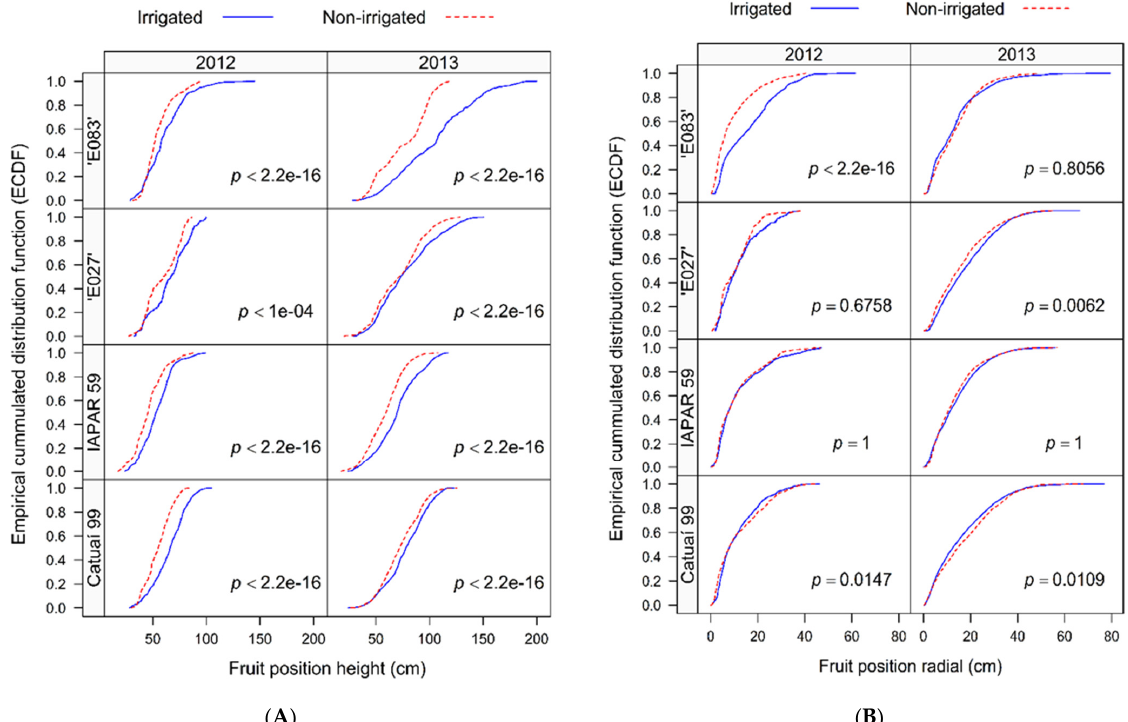
Figure 4. Empirical cumulative distribution function (ECDF) for berries along the ( A ) height of the canopy and ( B ) radial plant profile analyzed for four genotypes of Coffea arabica cultivated under two water regimes (irrigated and not irrigated). The p ‐ values are shown ( n = 4), comparing water regimes, separately for each genotype and harvest year (2012 and 2013). Additionally, the radial berry distribution (horizontal distribution over x ‐ and y ‐ axes) was also assessed, showing slightly delayed berry accumulation over the plagiotropic branches in NI compared to IRR in Catuaí 99 plants, in both harvest years (Figure 4B). The opposite, i.e., the delayed berry accumulation over the plagiotropic branches in IRR than in NI plants was calculated for ‘E083 in the 1st harvest year and for ‘E027 ′ the 2nd harvest year. The radial berry occupation zone referent to trunk attained the maximum from ca . 40 cm (‘E027 ′ ) to 60 cm (‘E083 ′ ) in the 1st harvest year. In the 2nd harvest year, the radial zone of berry occupation attained the maximum from ca . 60 cm (Iapar 59) to 80 cm (‘E083 ′ and Catuaí 99). 3.3. Components of the Berry and Bean Yields at Plant Scale Dependent on Water Regime, Genotype, and Local Light Availability In the 1st harvest year (2012) the yield components (fresh dry mass (FM), dry mass (DM), processed bean mass (BM)), and mass performances were positively impacted by irrigation in the three analyzed genotypes (Table 1). In this year, greater initial berry moisture (indicator of delayed fruit maturation), and lower processed bean mass performance were found in Catuaí 99 than in ‘E083 ′ , while Iapar 59 showed intermediary values. In the 2nd harvest year (2013), important increments in berry FM, DM, and bean BM were obtained due to supplementary irrigation, as compared to NI values (Table 1). Those increments were higher for two Ethiopia accessions than for two cultivars, although ‘E083 ′ and Iapar 59 did not differ as regards their absolute values under IRR conditions. The mass performances were positively impacted by irrigation for ‘E027 ′ and Iapar 59, while